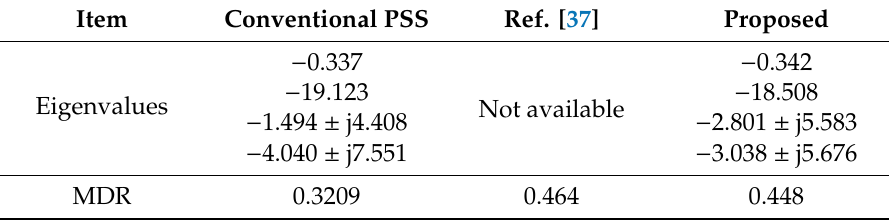
Table 8. Eigenvalues and MDR comparison for the operating situation # 2 (first network).